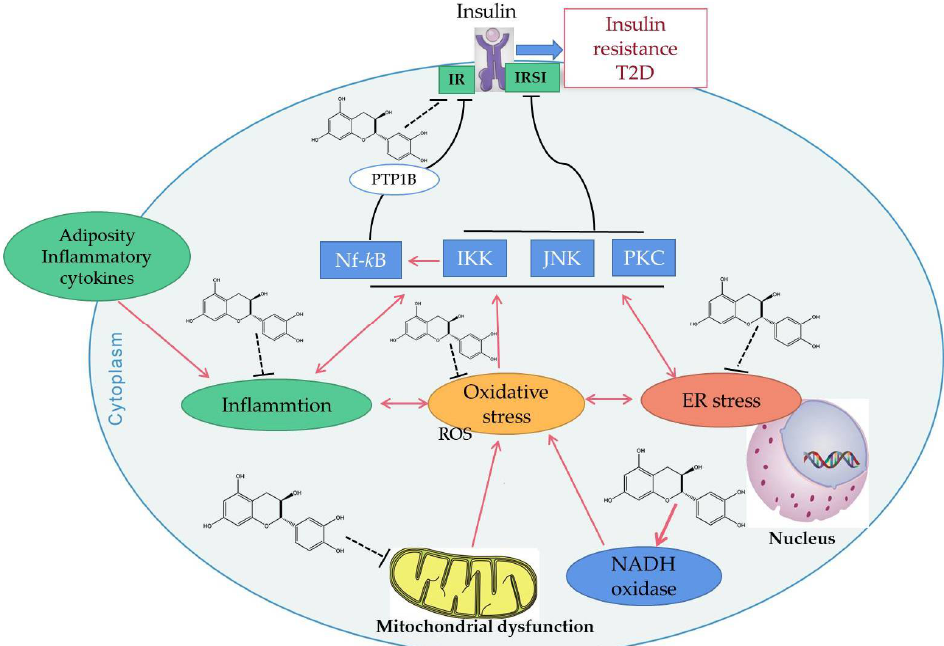
Figure 3. Possible mechanisms of catechins improving insulin resistance. Adiposity or inflammatory cytokines may lead to inflammation, oxidative stress and endoplasmic reticulum (ER) stress inside the cell. All of these stresses activate c-Jun N-terminal protein kinase (JNK), inhibitory κB Kinase (IKK), and the protein kinase C (PKC) signaling pathway, by which the function of insulin receptor substrates 1 (IRS1) is suppressed, decreasing its capacity to regulate downstream events in the insulin cascade. In addition, protein tyrosine phosphatase 1B (PTP1B) will be up-regulated by the activated IKK/NF-κB signaling pathway. This response will result in dephosphorylation and inactivation of the insulin receptor (IR) and insulin receptor substrates 1. Catechins have been confirmed to change the oxidative stress events by inhibiting the ROS production of mitochondria, resulting in inhibiting the activation of a series of intracellular signal pathways and reducing the occurrence of insulin resistance. Red solid arrows indicate upregulation or activation, black solid lines indicate inhibition, black broken lines indicate inhibition of catechins.